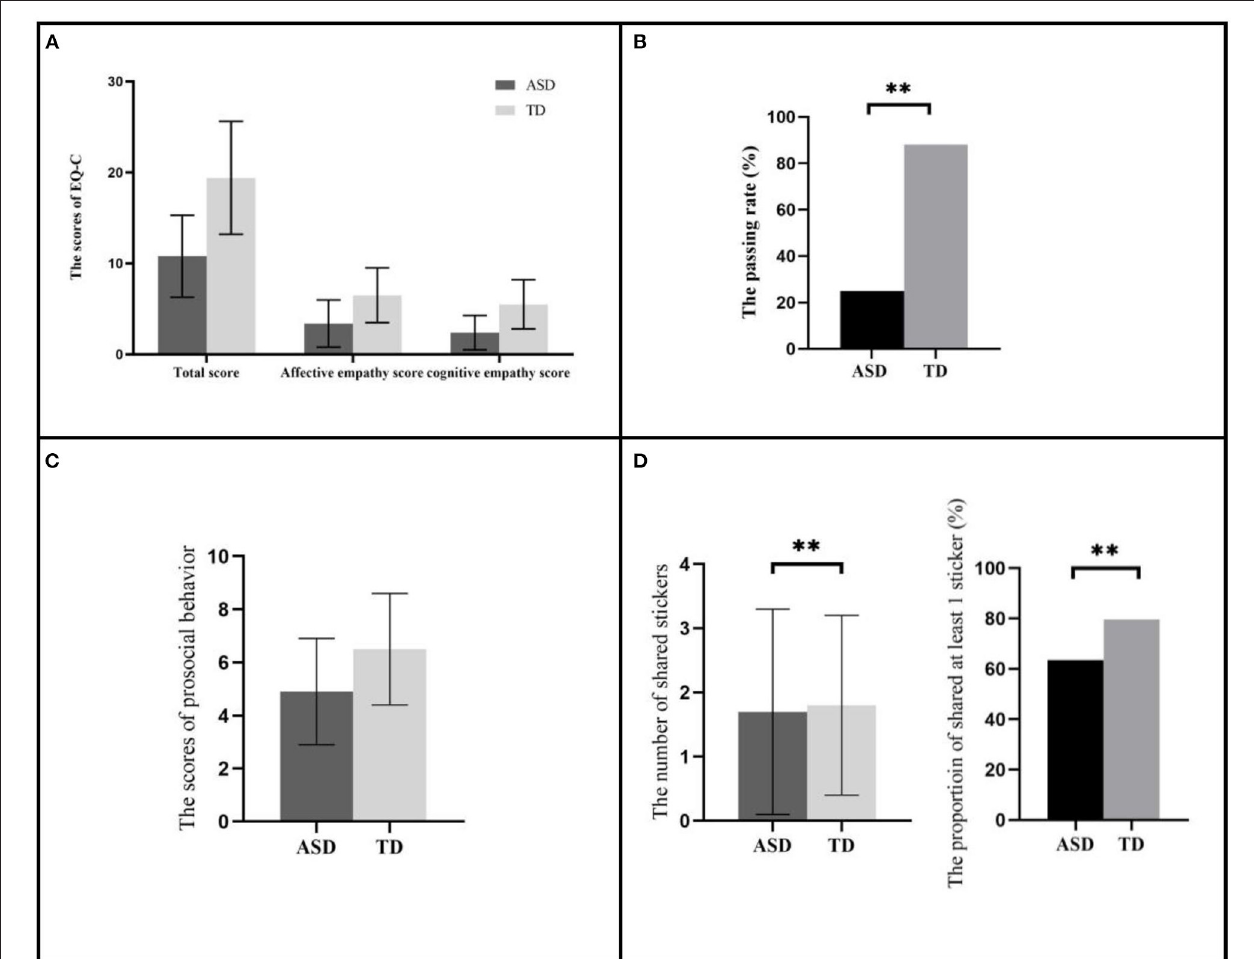
FIGURE 1 | The comparison of empathic traits, ToM ability and prosocial behaviors between autistic children and TD children. (A) The comparison of EQ-C scores between the two groups. (B) The comparison of passing rate of the ToM toolkit between the two groups. (C) The comparison of prosocial behaviors score between the two groups. (D) The comparison of the number of shared stickers and the proportion of shared at least 1 sticker in DG paradigm between the two groups. All the comparison were adjusted for child’s age, child’s sex, FSIQ, SRS total score, BRIEF total score, maternal age, maternal education level and per capita monthly household income. The comparison of prosocial behavior in DG paradigm was further adjusted for degree of stickers preference. ASD, Autism spectrum disorder; TD, Typically developing; EQ-C, Children’s version of Empathy quotient; ToM, Theory of mind. ** P <